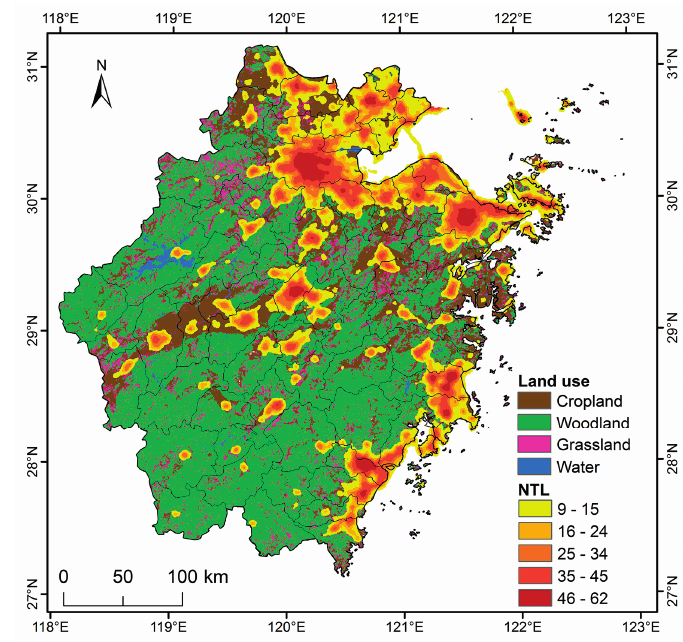
Figure 2. The fusion of DMSP/OLS NTL image and GlobCover land cover data for Zhejiang